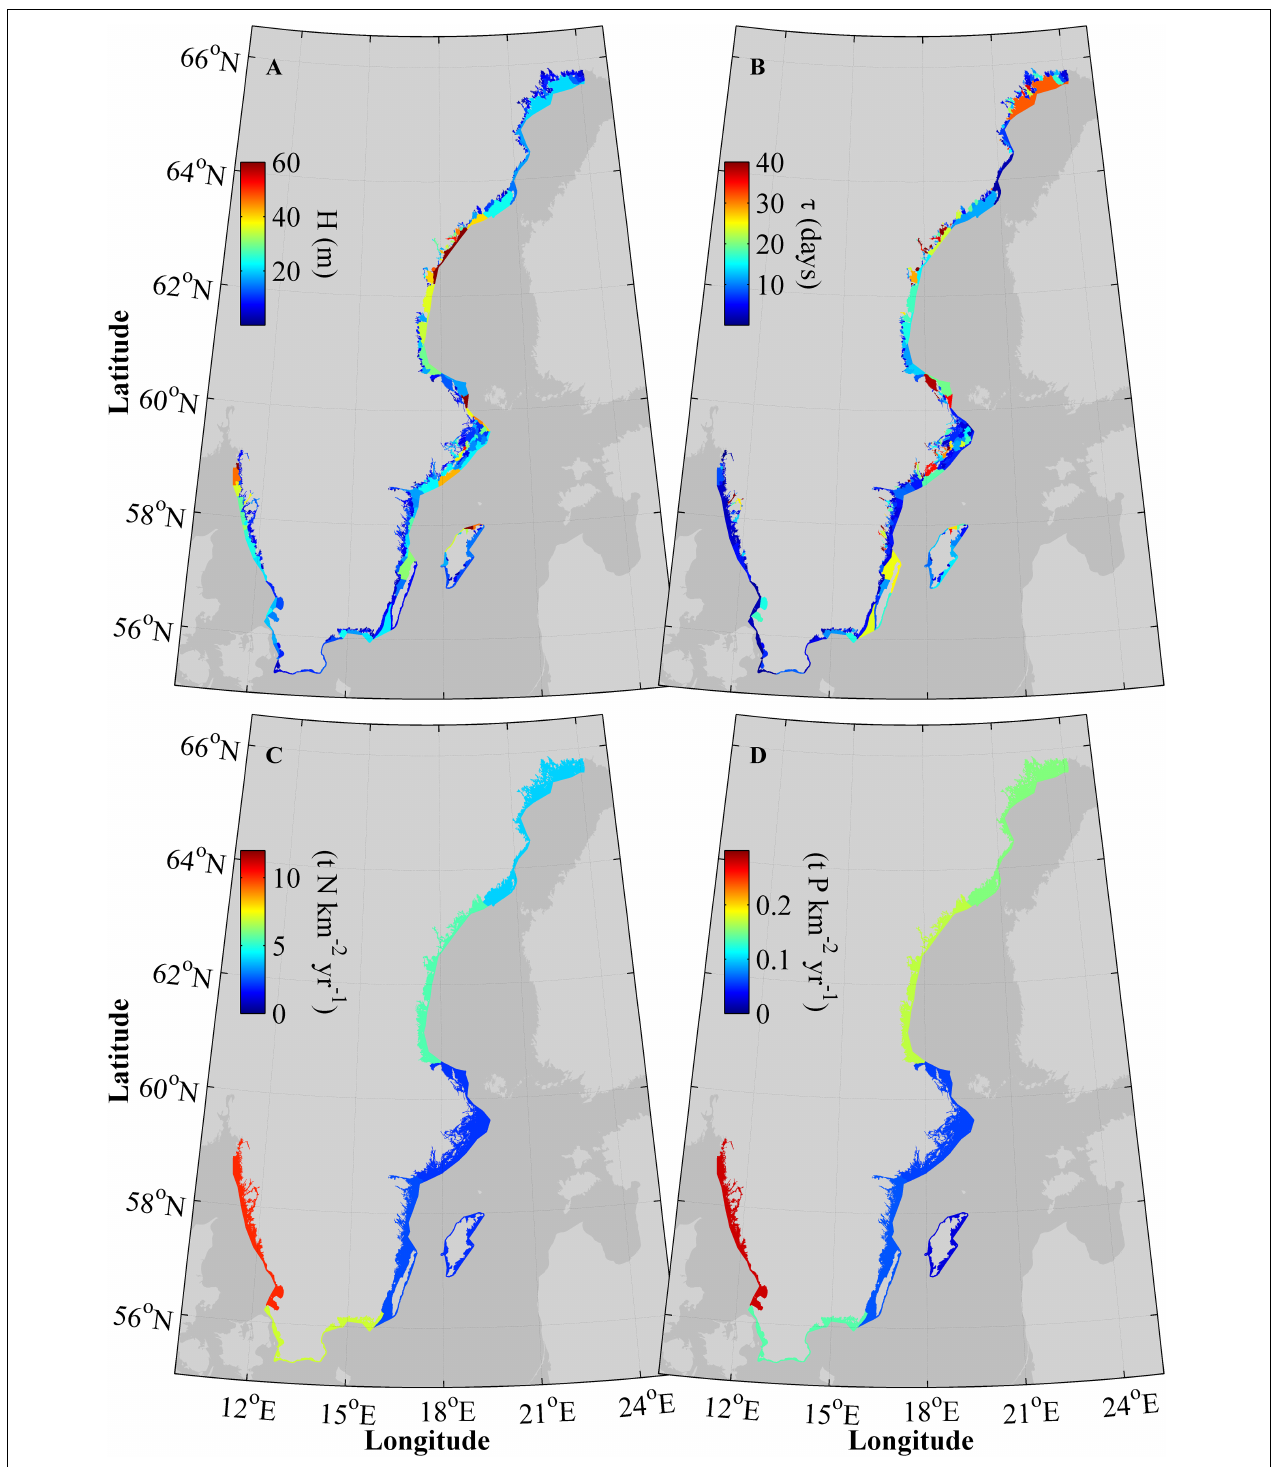
FIGURE 3 | Mean depth, H , (A) and average age, τ , (B) for the individual water bodies along the coast, and land load (S-HYPE and point sources) normalized to area (C,D) for the seven MRs.